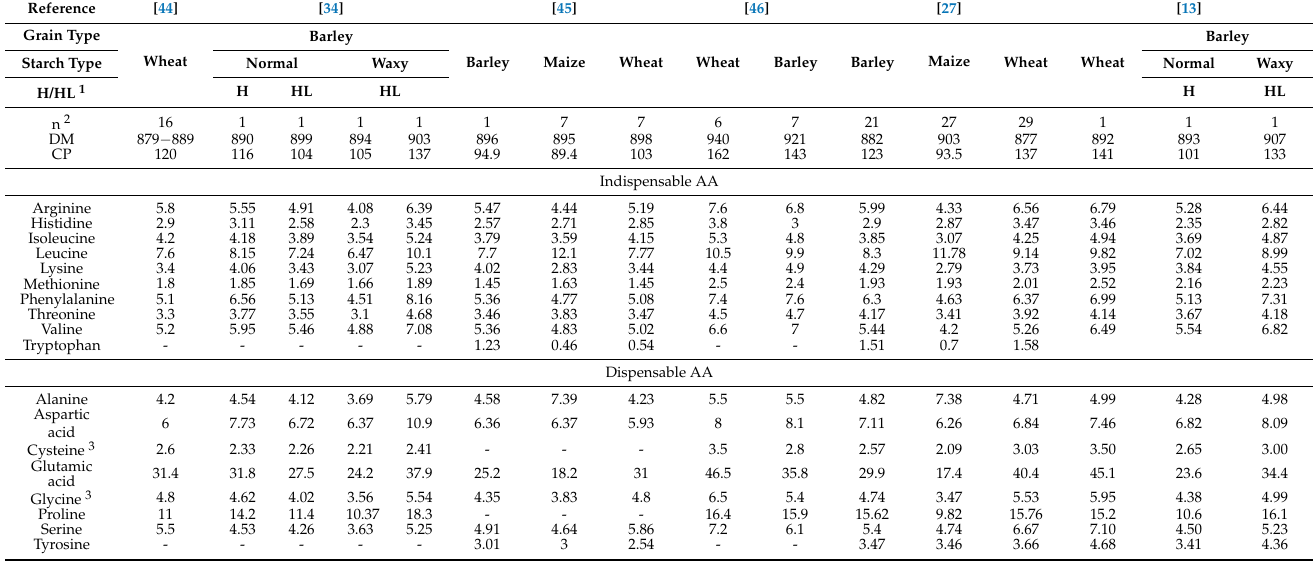
Table 2. Crude protein and amino acid (AA) composition of barley, maize and wheat (g/kg,